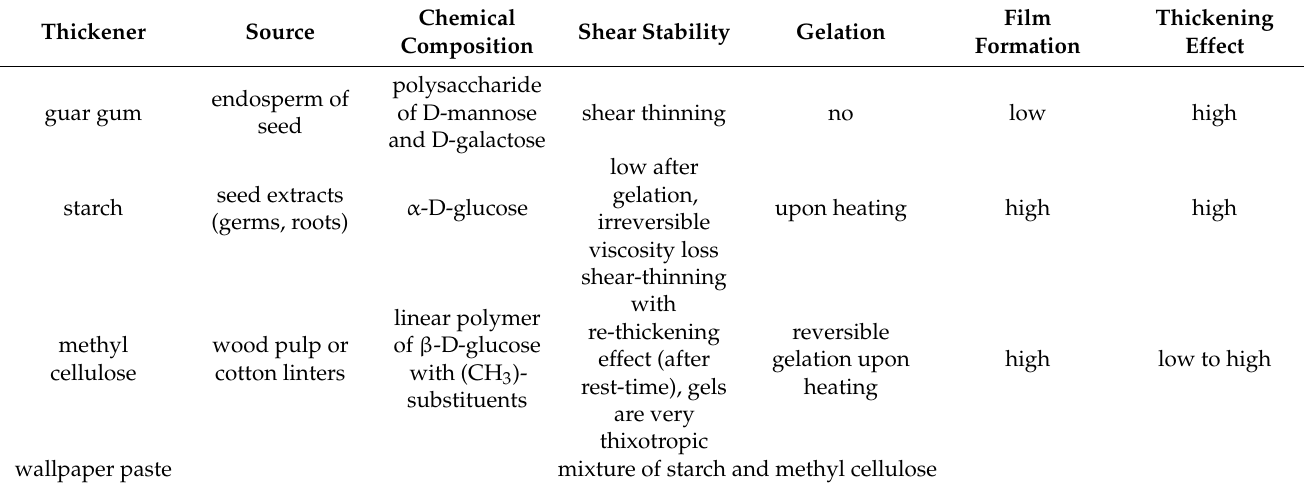
Table 2. Characteristics of thickening agents used (after [31]).